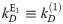
Single enzymes versus enzyme-enzyme complexes.(a) Enzymes E1 and E2 consist of Lennard-Jones (LJ) spheres of radius ≈0.37 nm placed on the surface of a sphere of radius 1.5 nm, where one of the LJ-spheres is treated as an active site. An enzyme complex (E12 = E1E2) is constructed by merging E1 and E2 together such that the active site of E1 is located on the axis connecting the centers of E1 and E2. The center-to-center distance between E1 and E2 is 1.4 nm. The substrate for E1 and E12 is a LJ-sphere of radius 0.4 nm. (b) Rates of the diffusion-limited enzyme-catalyzed reactions for the first enzyme in a tandem reaction (denoted by kDE1≡kD(1)) and for the enzyme-enzyme complex (denoted by kDE12≡kDch). The rates are shown as functions of the strength of the LJ potential between the substrate molecule and the LJ particles of the enzymes (ϵLJ). These rates were calculated by using Brownian dynamics simulations (see Methods).